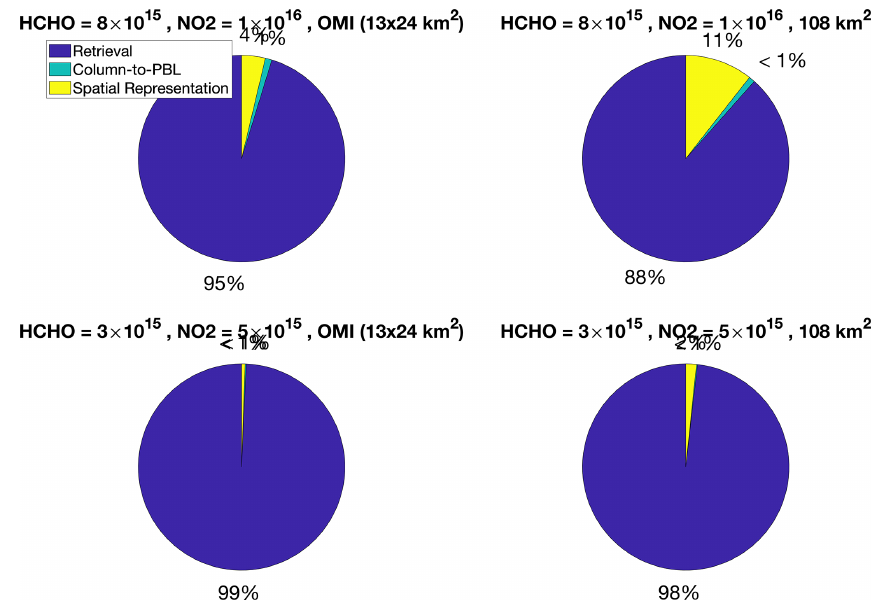
Figure 15. Same as Fig. 14 but based on OMI sigma